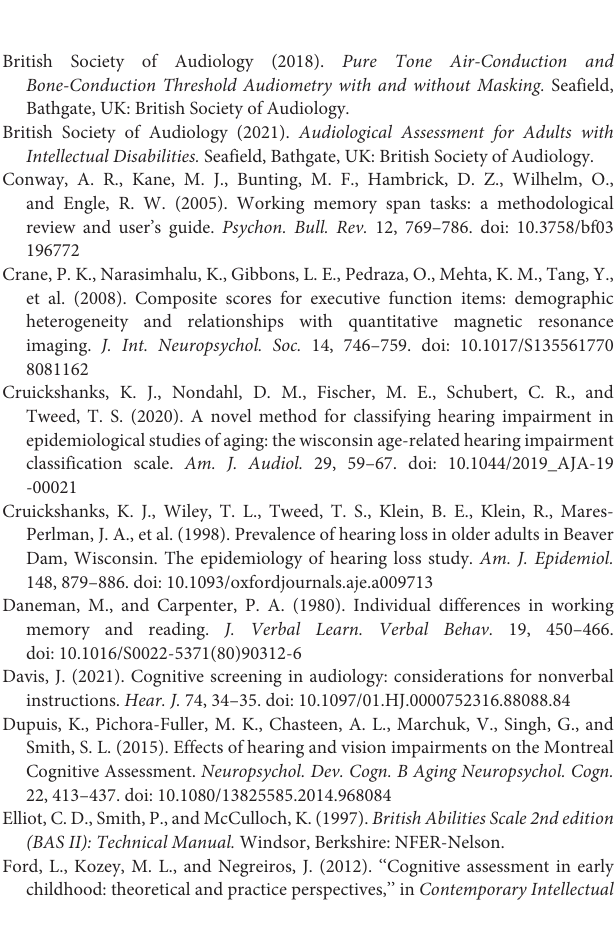
Supplementary Figure 1 | Performance (with a maximum score of 70) for the two short-term-memory tasks (Forward Digit Span, FDS; Letter Span, LS) and the two working-memory tasks (Operation Span, OS; Reading Span, RS). Horizontal thick bars indicate the median, the light-gray-shaded boxes represent the interquartile range, and the open circles denote individual data points. Overlapping data points are displaced horizontally for better